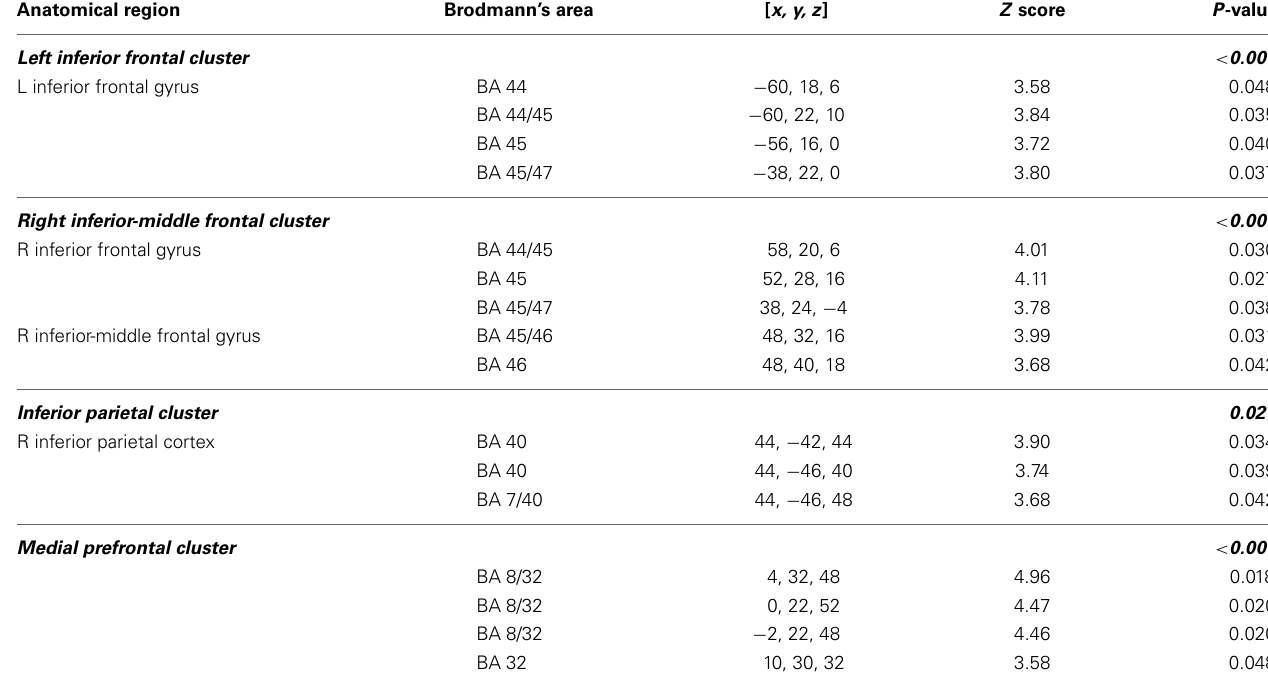
Table 4 | Implicit learning